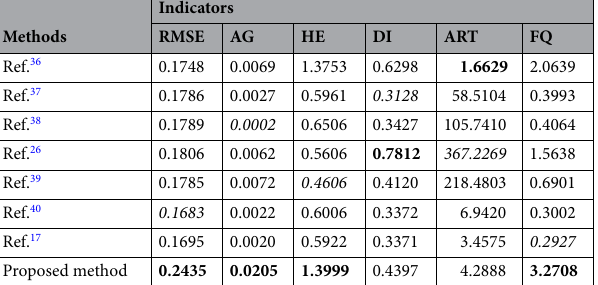
Table 2. Average performance indicators of different fusion methods. Significant values are in [bold and italics].